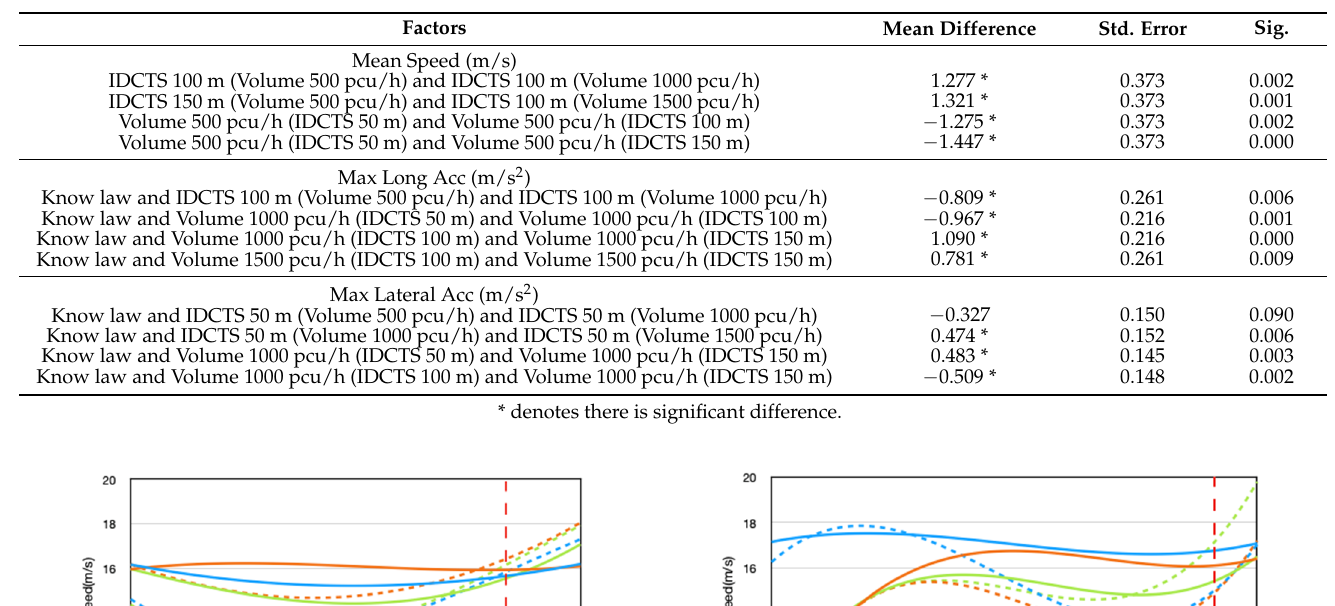
Table 5. Result of pairwise comparisons.